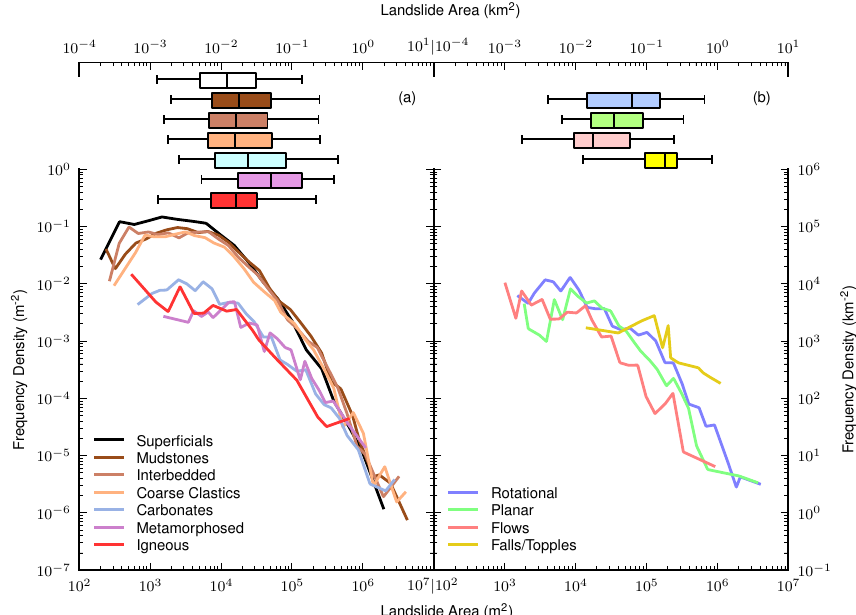
Figure 4. (a) Frequency distributions classified into broad lithologic groups for bins spaced evenly in logarithmic space. Table 1 provides details of the number of landslides in each group and the MLE parameter estimate for α for an assumed power-law distribution of medium- large landslides. Box plots show the median and lower / upper quartile statistics of area data for each lithologic group (whiskers are 5th and 95th percentiles). (b) Frequency distributions classified by type of mass movement process; rotational slides, planar slides, flows and falls / topples. Box plots show the median and lower / upper quartile statistics of area data for each lithologic group (whiskers are 5th and 95th